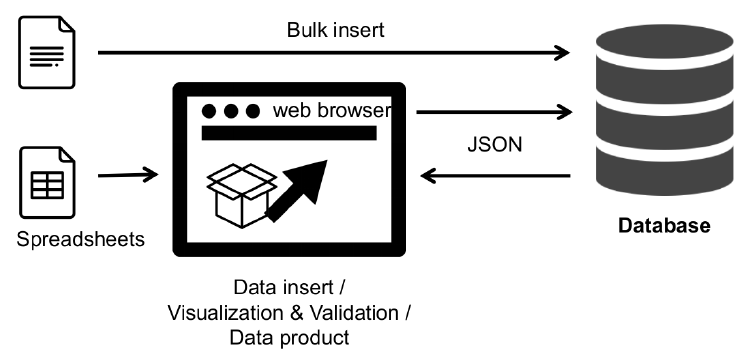
Figure 4. Schematic view of changed “two way” data